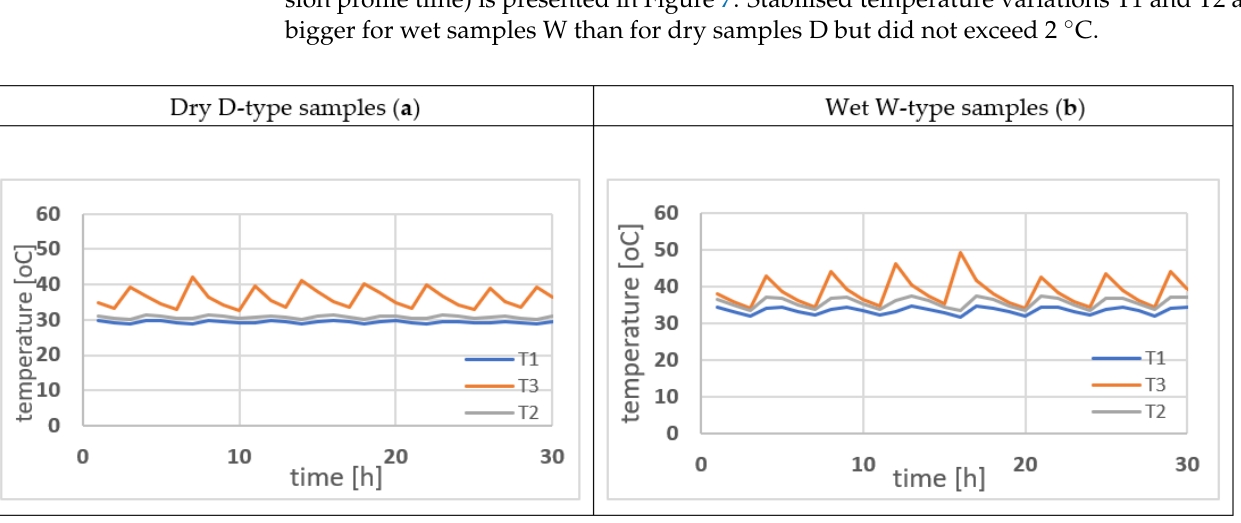
Figure 7. Stability of temperature for the top layer T1, inside layer T2 and heater T3 in time for dry D-type samples ( a ) and wet W-type sample ( b ).